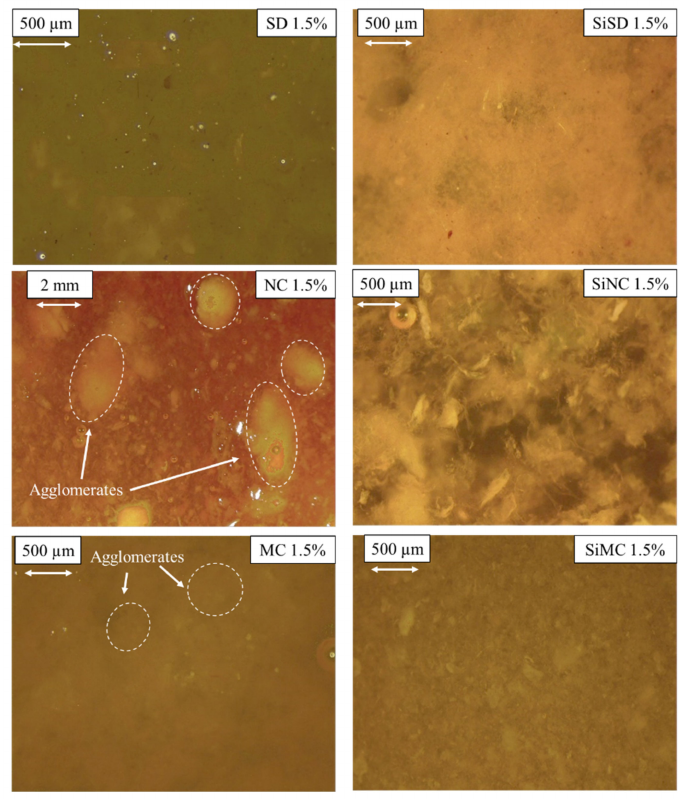
Figure 9. Dispersions of fillers in polyol mixture for 1.5% PP40